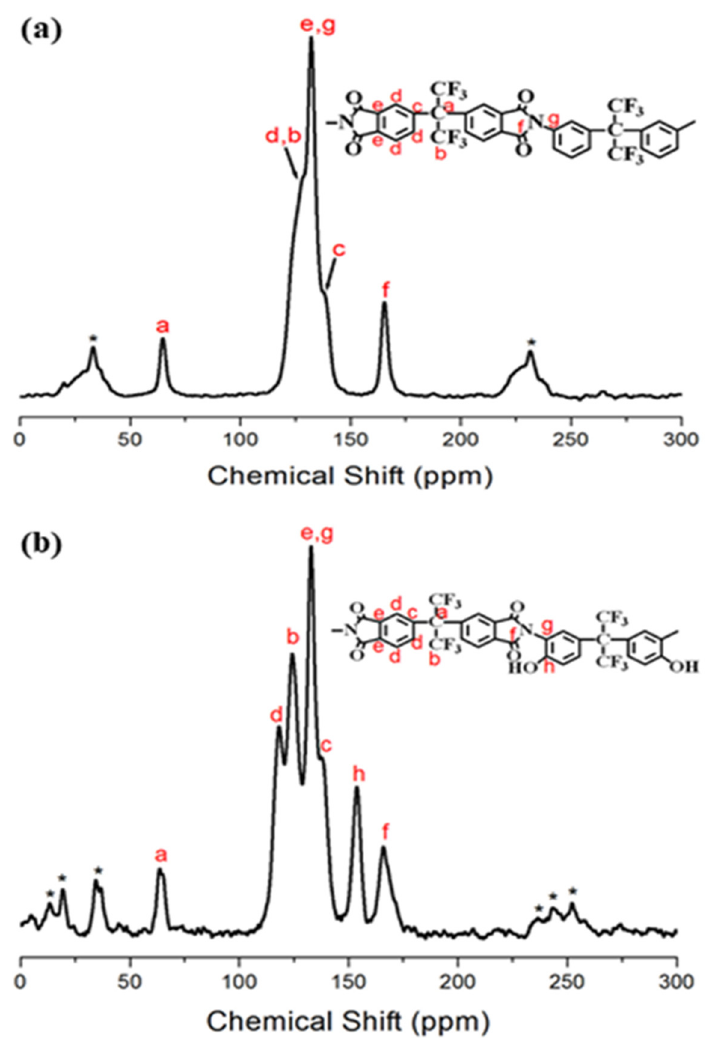
Figure 2. 13 C-NMR spectra of pure CPI films containing ( a ) 6FAm and. ( b ) 6FAm-OH. The spinning sidebands are marked with asterisks.